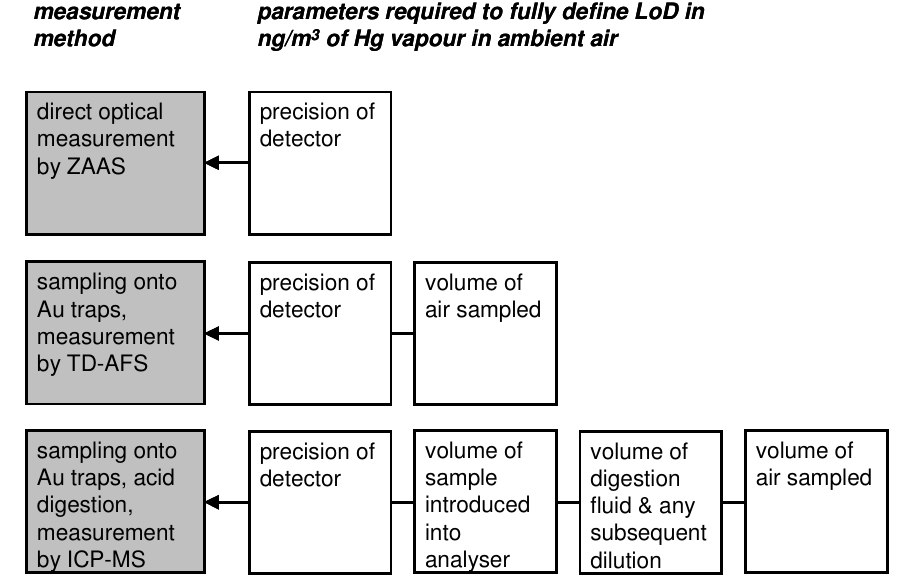
FIGURE 2. The parameters required to define and describe fully the LoD for the measurement in ng/m 3 of Hg vapour in ambient air by three measurement methods: direct optical measurements by ZAAS,